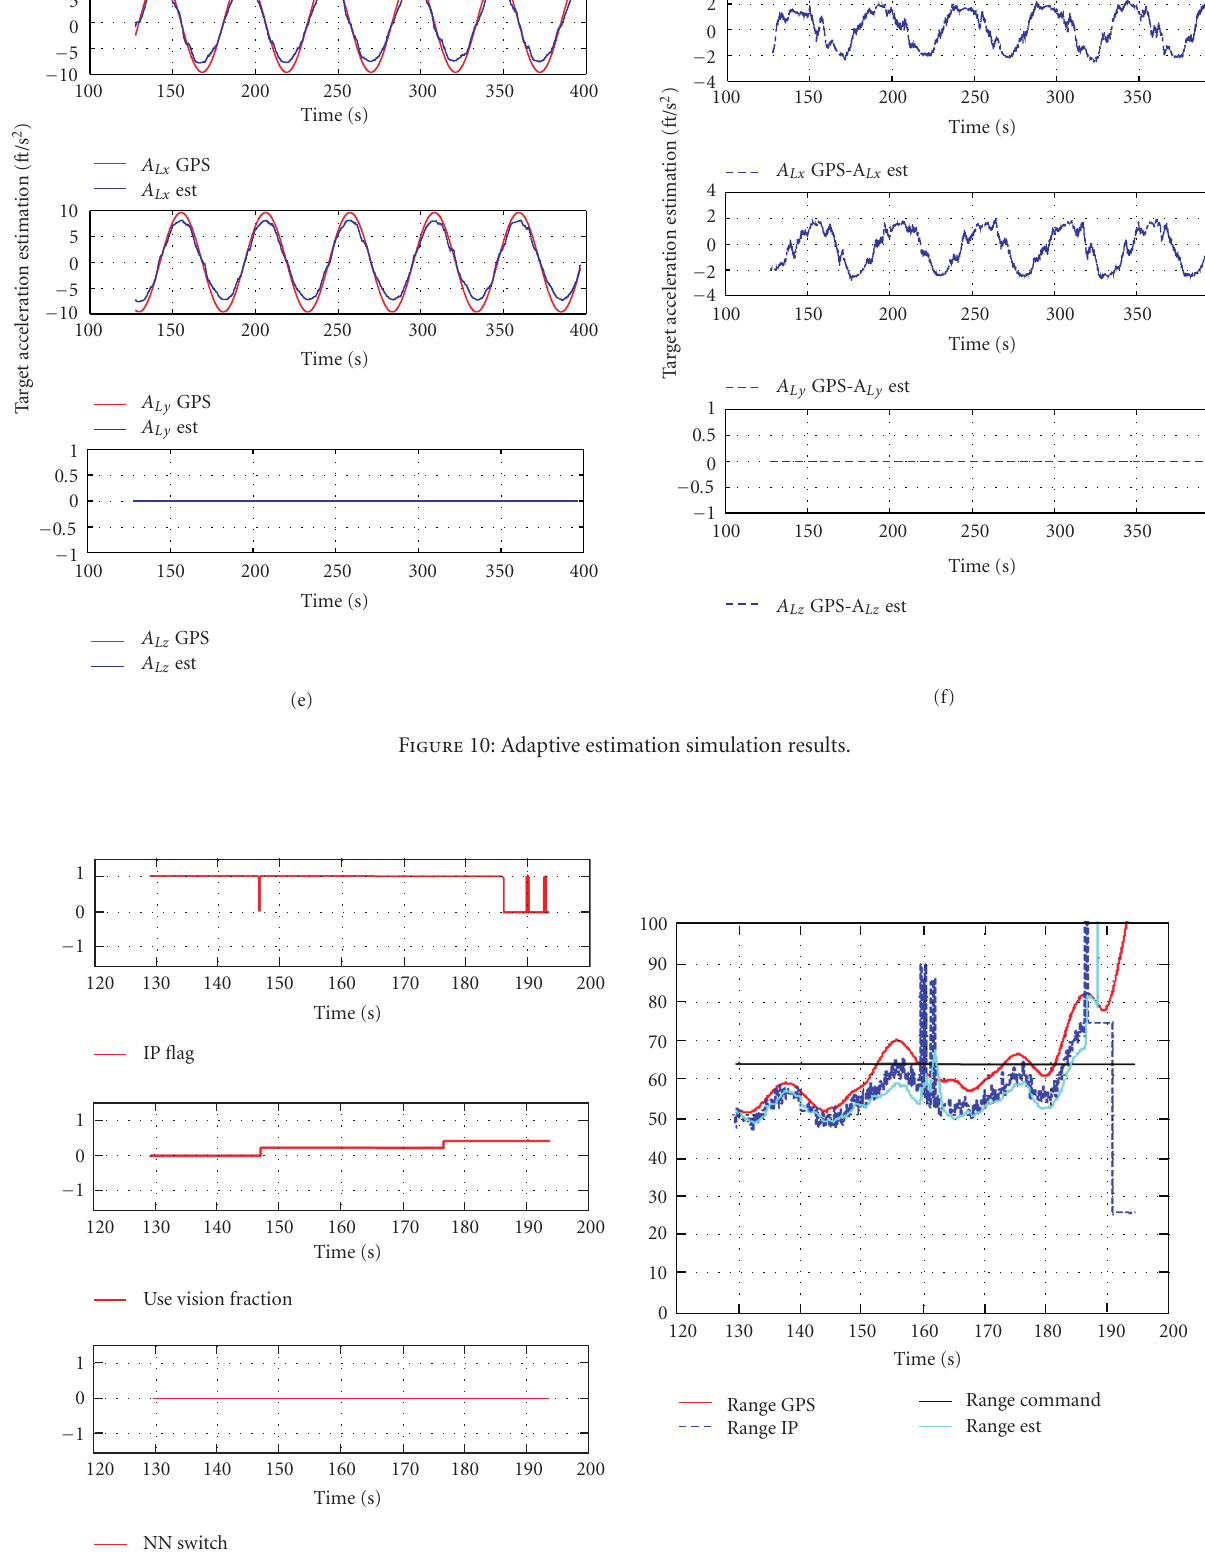
Figure 11: Range estimation without the adaptive